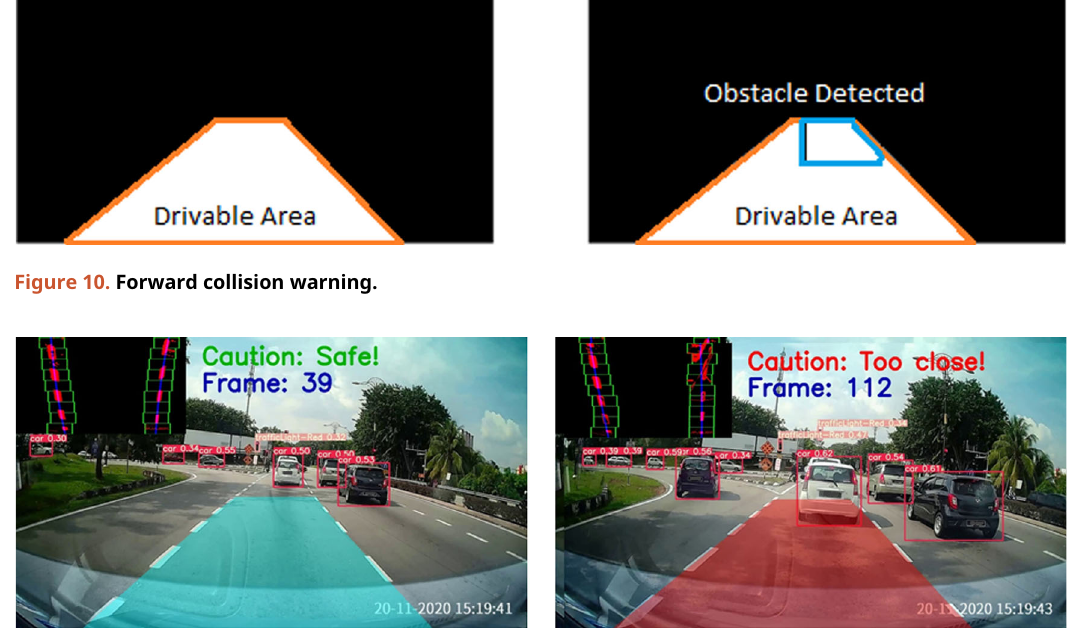
Figure 11. Samples for forward collision warning